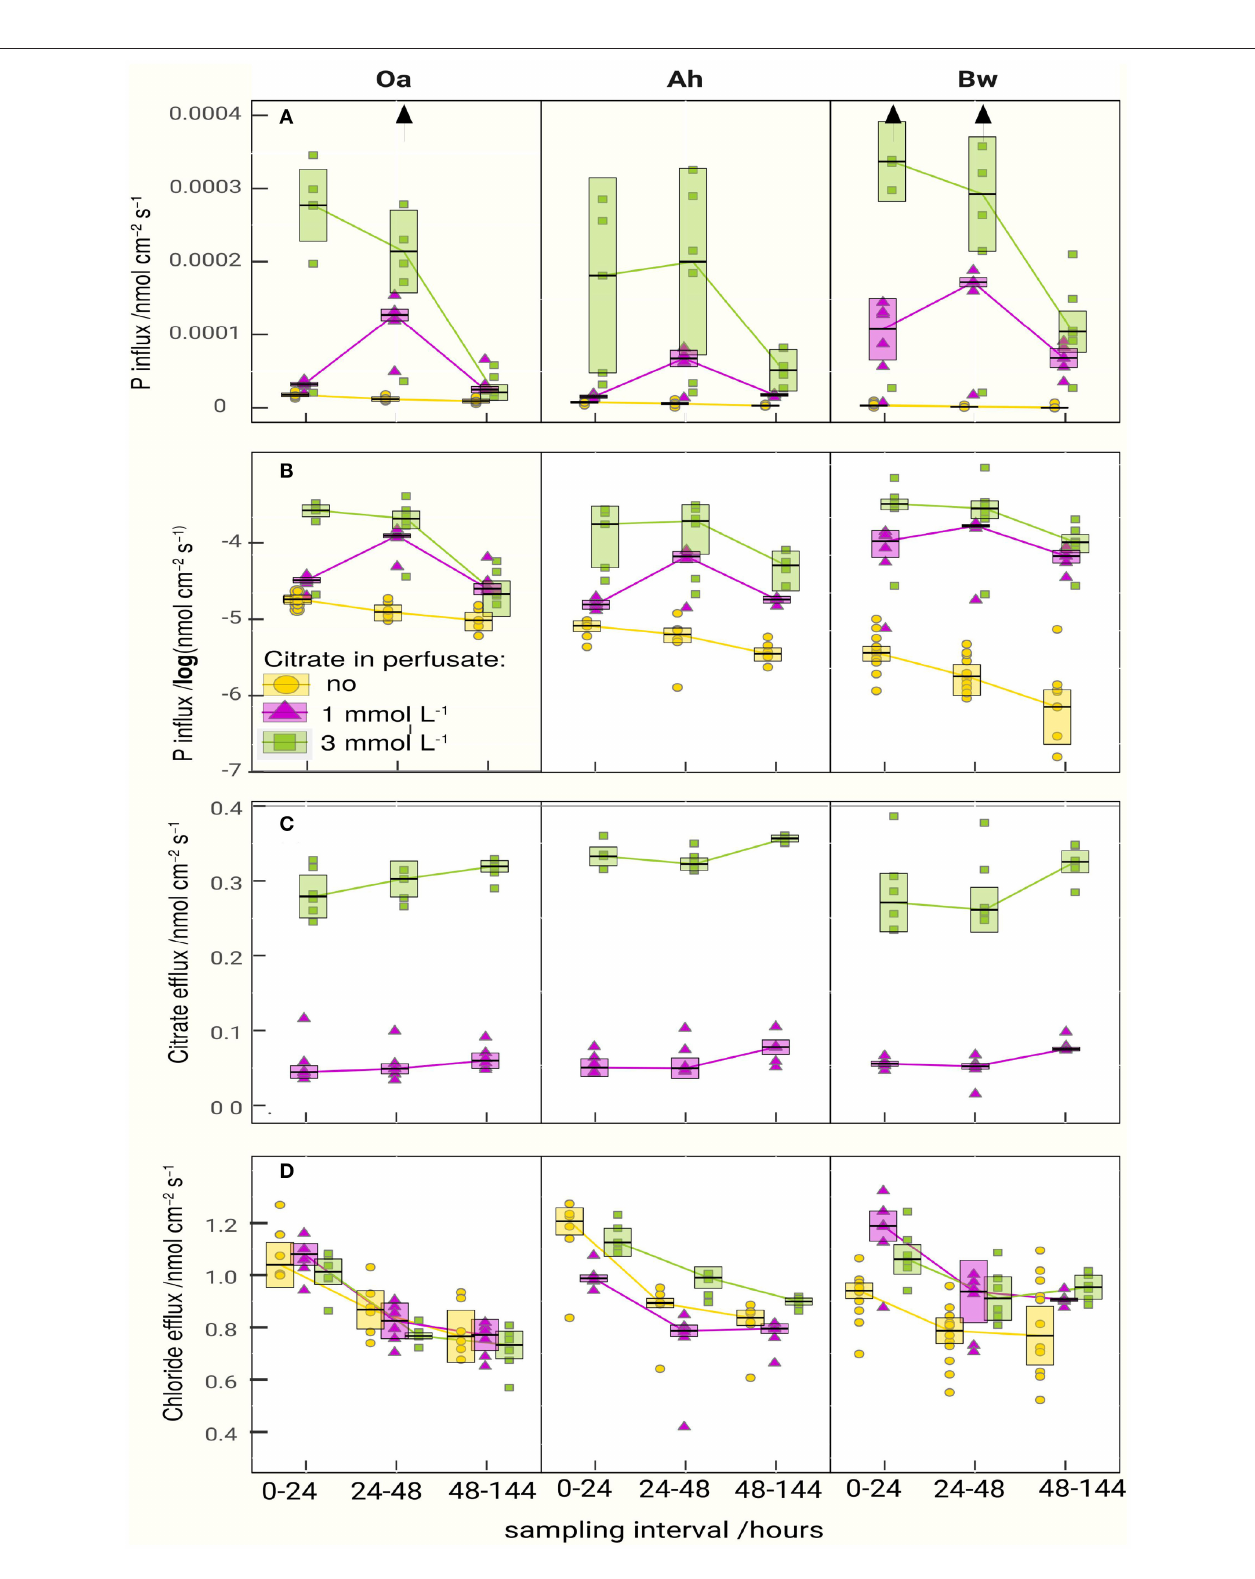
FIGURE 2 | Fluxes of phosphate (A,B) , citrate (C) , and chloride (D) between soil and microdialysis probes. The boxes represent the approximated 95% confidence limit of the median (anova statistics is presented in Table 3 ). The lines are connecting medians indicating the temporal pattern. For the phosphate influx, the plot is repeated with logarithmic scaling in (B) to highlight the gradation of the P-absorption between control and citrate treatments. Vertical arrows in the upper graph symbolize outliers beyond the maximum axis value.